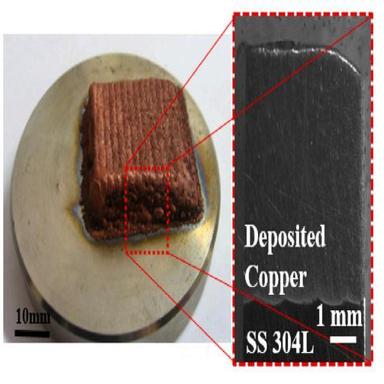
LDED Deposited Cu bulk at constant LEPF scheme (a) 9 kJ/g (b)12 kJ/g (c)15 kJ/g (d) 22.5 kJ/g.